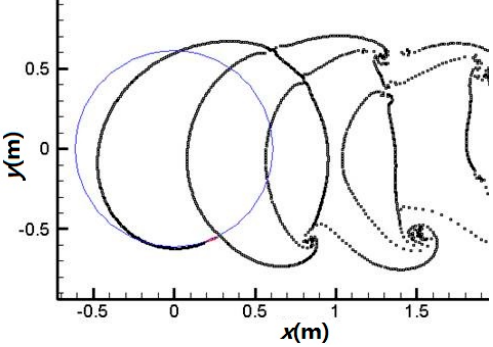
Figure 5. Shed vortex central path predicted by the present study (Turbine A λ = 5, Z = 1).